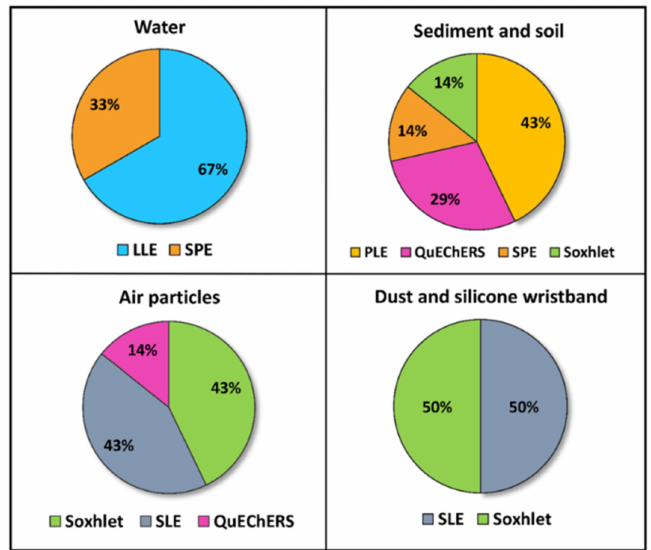
Figure 3. Percentage of articles (2019–2021) according to the extraction procedures applied in every environmental matrix studied (Source: Table 1). LLE: liquid–liquid extraction; SPE: solid-phase extraction; PLE: pressurized liquid extraction; QuEChERS: Quick, Easy, Cheap, Effective, Rugged, and Safe extraction